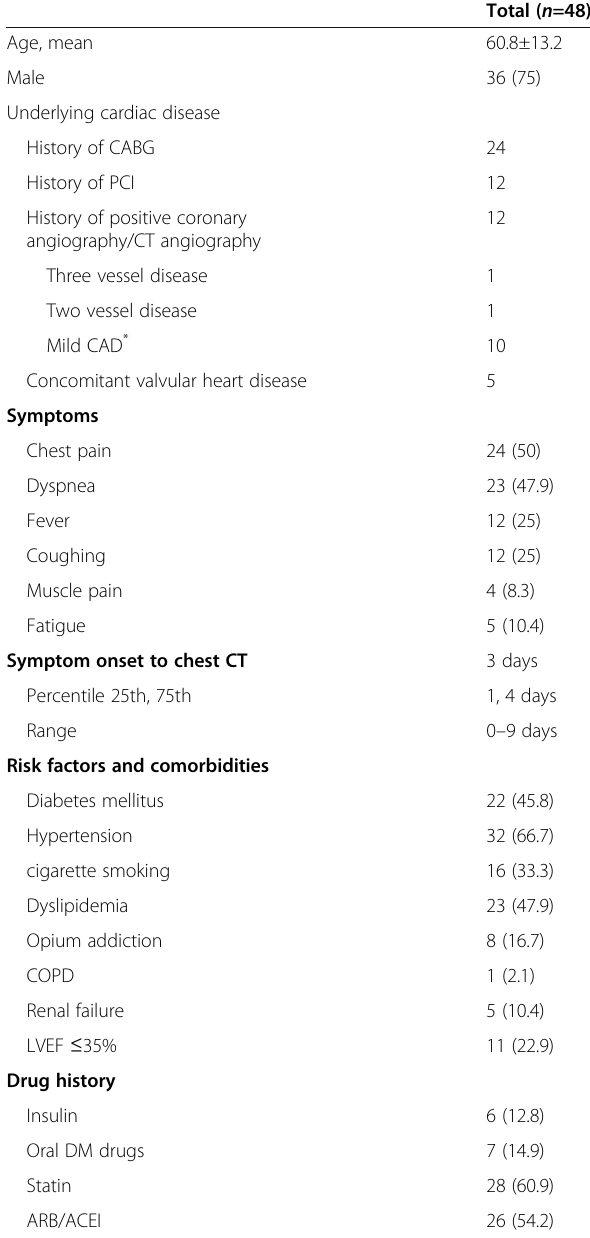
Table 1 Demographic and clinical findings of the study